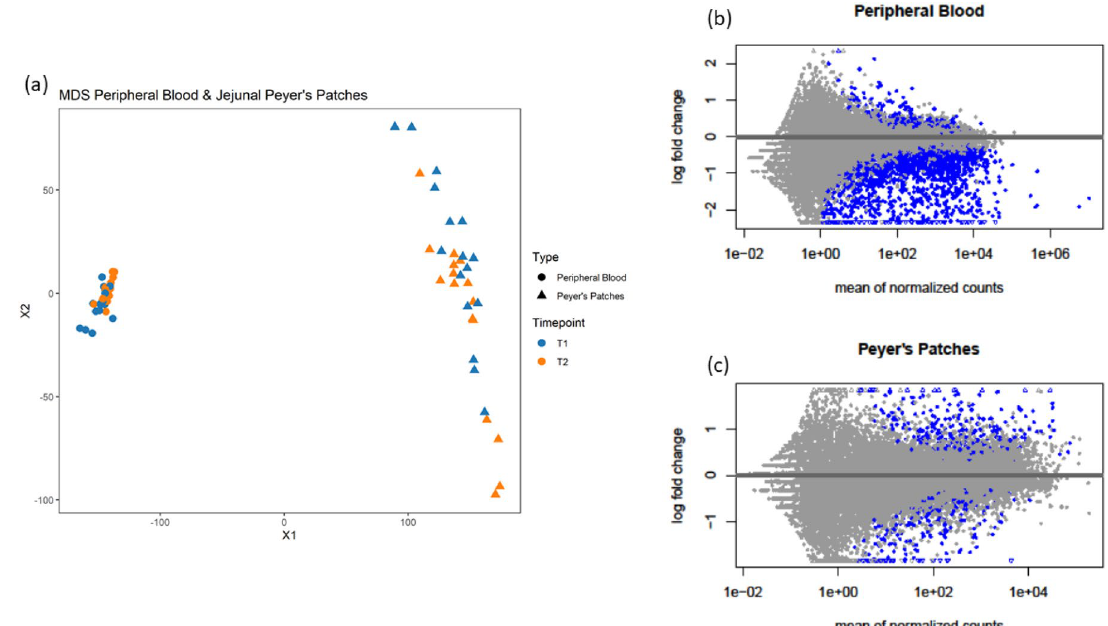
Figure 1. Summary plots of the gene expression profile of JPPs and PB at different times. The plots were multidimensional scaling (MDS) plots for the normalised gene expression levels of JPPs and PB at weaning (T1) and at 12 days post-weaning (T2) ( a ), and smear plots of the differential expression of the genes between T1 and T2 for JPPs ( b ) and PB ( c ), respectively. The smear plots show the relationship between the log fold change and the mean normalised count. The grey points represent non-significant differentially expressed genes whereas the blue points show genes which are significantly differentially